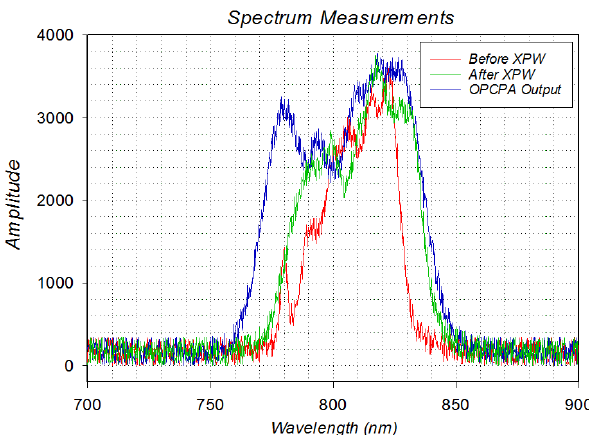
Figure 4. Spectrum measurements of the frontend laser system. The red, green, and blue curves are the profiles before the XPW filter, after the XPW filter, and out of the final OPCPA amplifier, respectively.